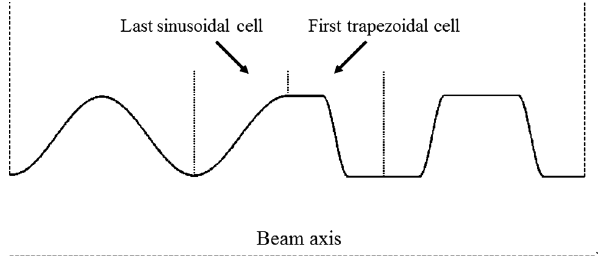
FIG. 3. Vane tip geometry showing the transition from sinu- soidal to trapezoidal modulation. Note that the horizontal and vertical dimensions are not to